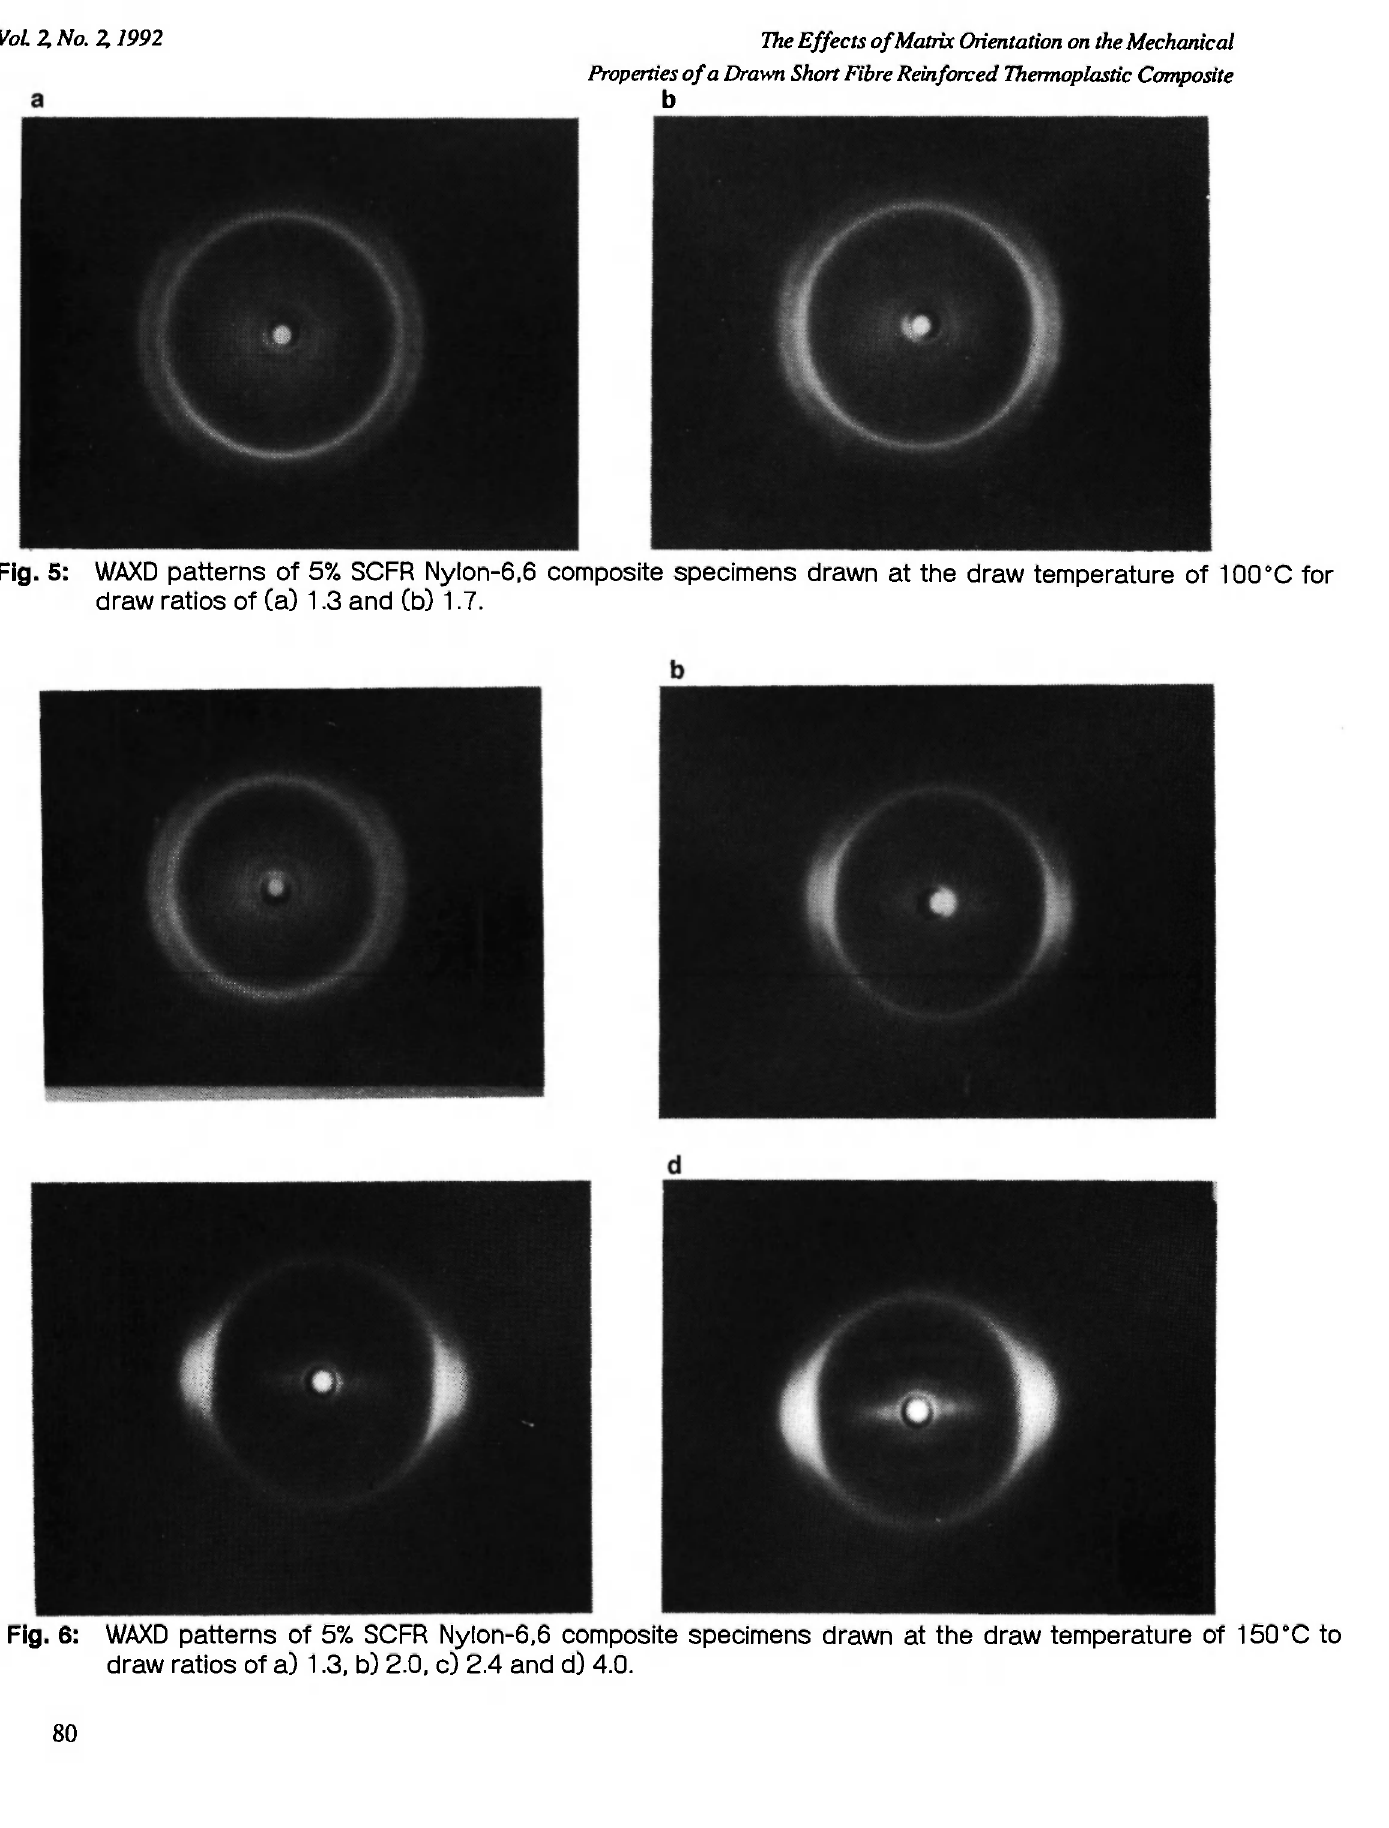
Fig. 5: WAXD patterns of 5% SCFR Nylon-6,6 composite specimens drawn at the draw temperature of 100°C for draw ratios of (a) 1.3 and (b) 1.7.